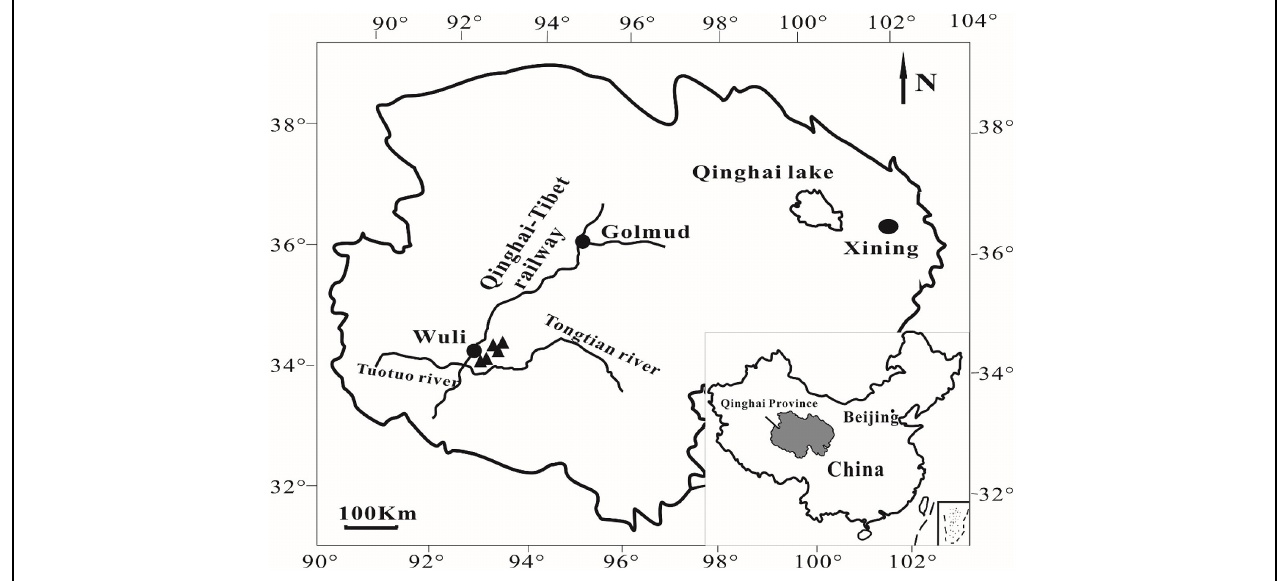
FIGURE 1 | A geographic map showing the locations of sampling sites in Wuli County, Qinghai-Tibet Plateau,